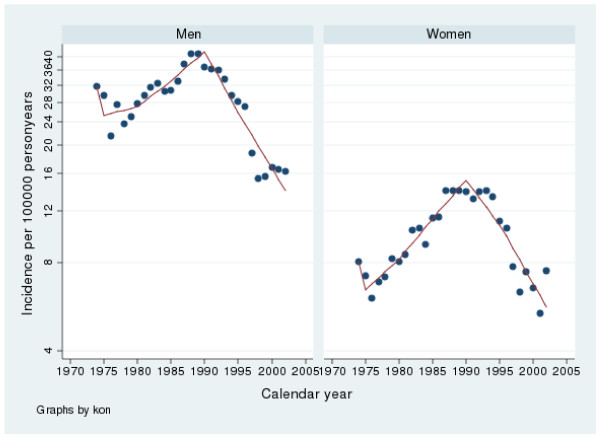
Incidence of duodenal bleeding peptic ulcers in Sweden from 1974 to 2002. Note that the y-axis has been truncated.